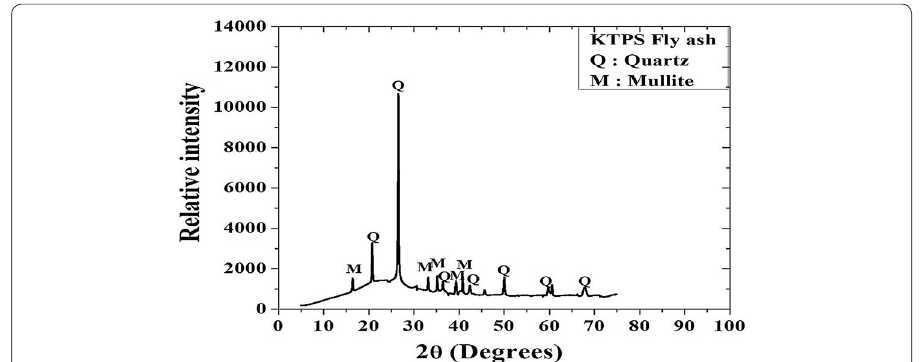
Fig. 4 X-ray diffraction pattern for KTPS fly ash sample